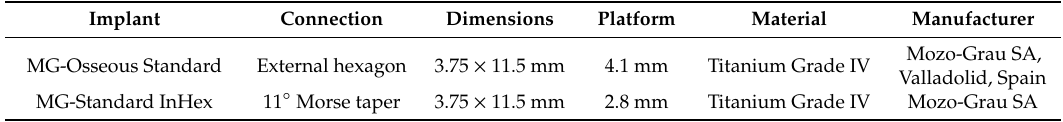
Table 1. Characteristics of the implants